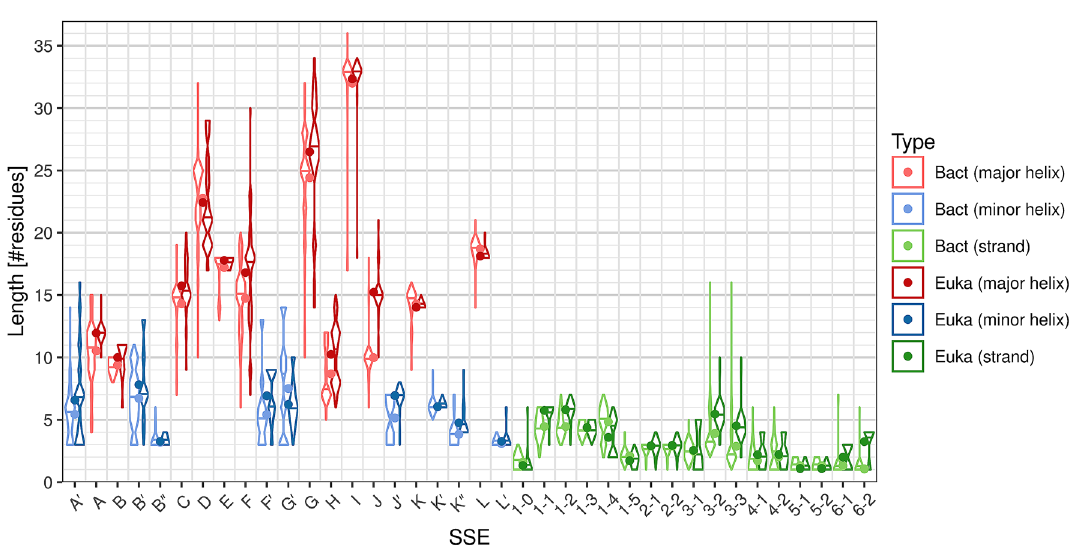
Figure 6. Comparison of SSE class length distribution in bacterial (Bact) and eukaryotic (Euka) CYP structures. The absent SSEs are not included in the